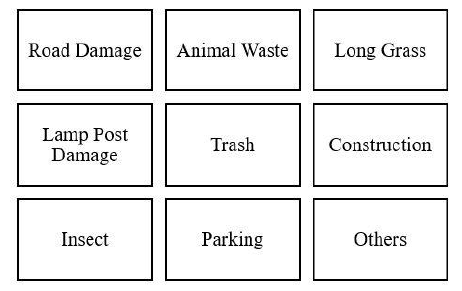
Figure 2. Category of complaints (source: interview